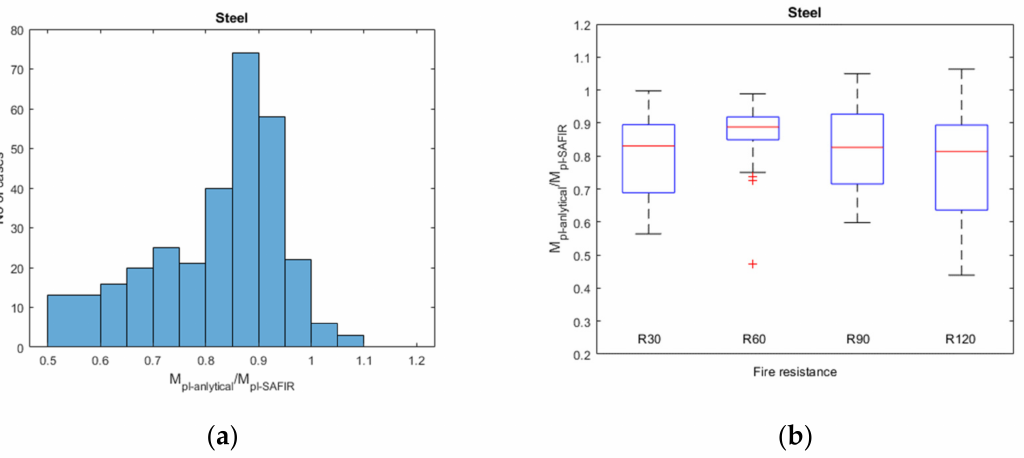
Figure 13. Assessment of the studied configurations with non-composite behavior: ( a ) Gauss curve; ( b ) boxplot